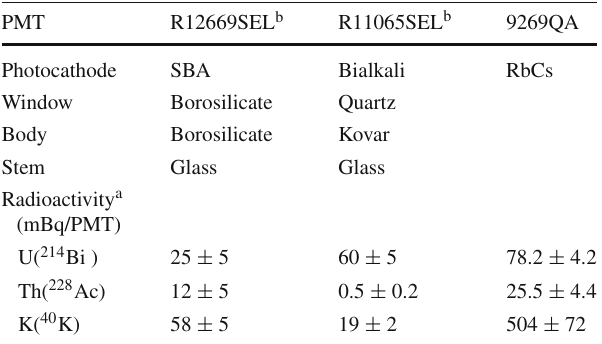
Table 2 Specifications for PMTs used in this study [13]. (a) The radioactivities were measured with a HPGe detector at Y2L. (b) SEL means “selected for high quantum efficiency”